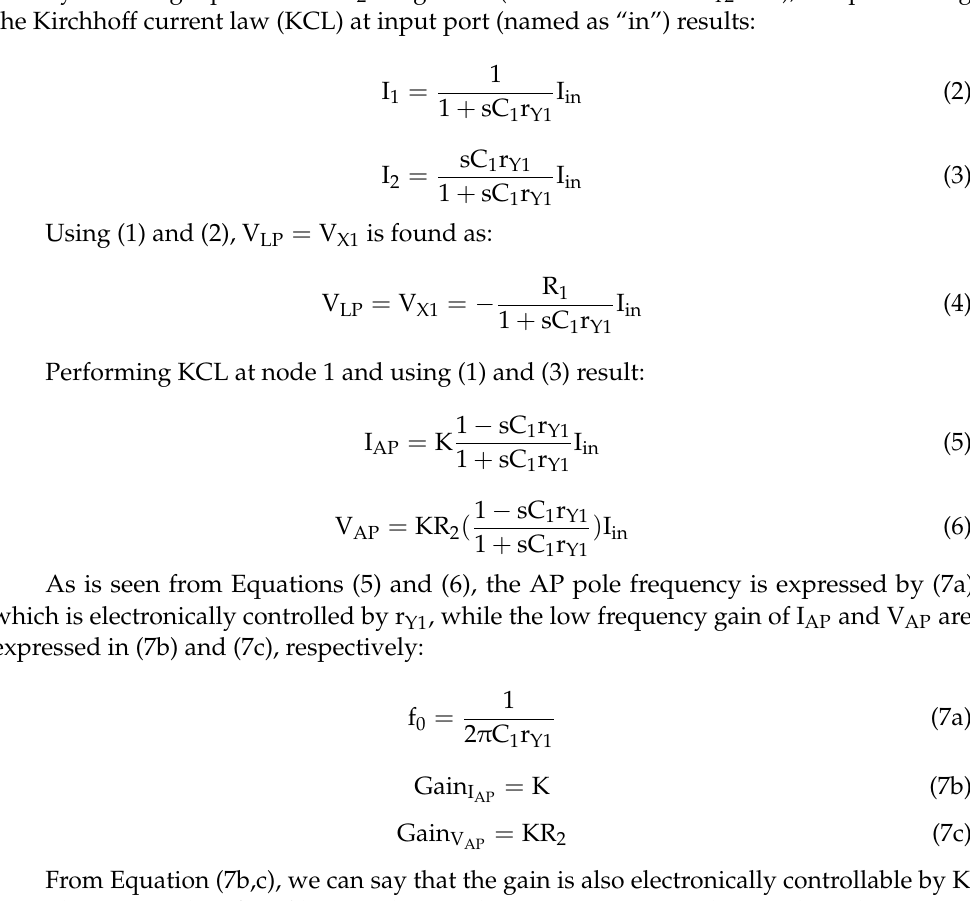
Figure 2. The proposed CVCII based low-pass/all-pass (LP/AP) filter topology. By assuming Y port of CVCII 2 + at ground (since in ideal case r Y2 = 0), and